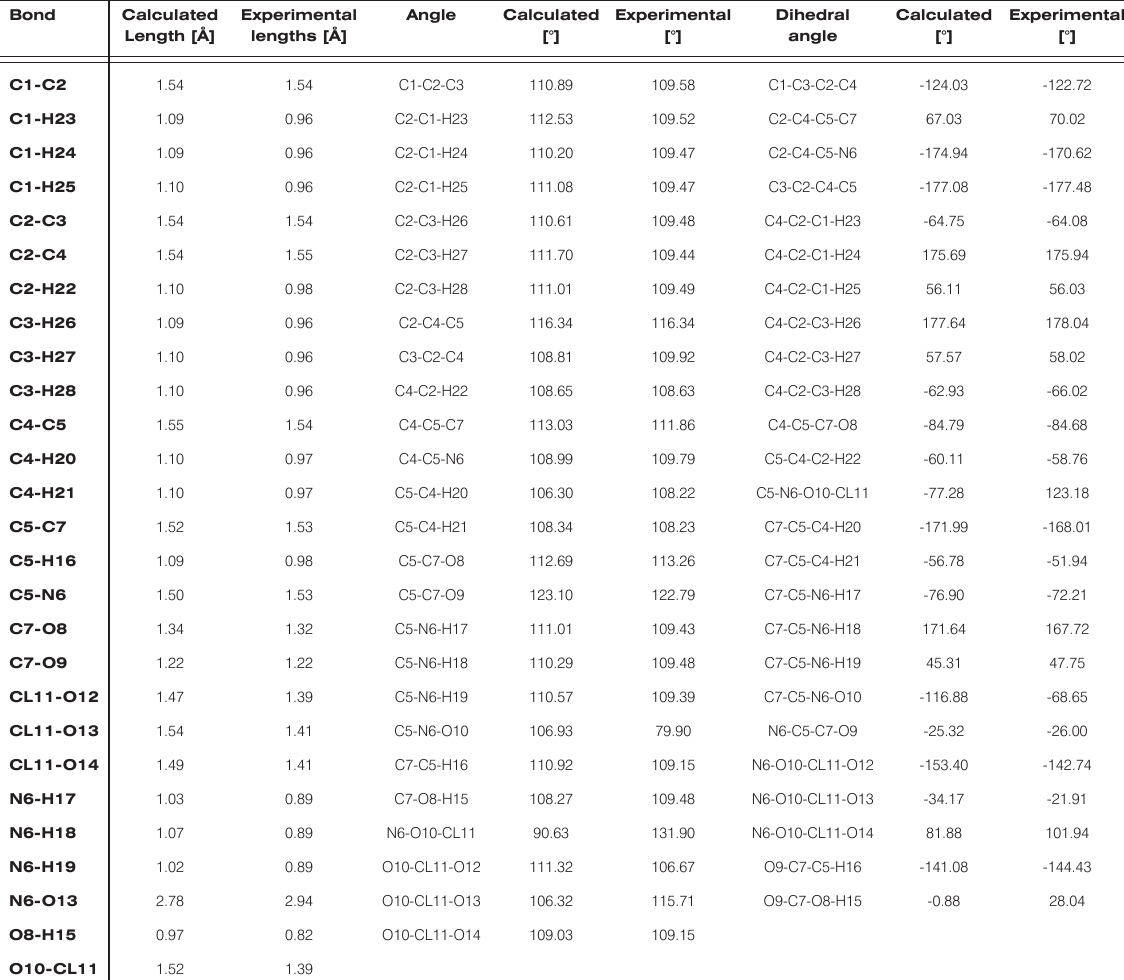
Table 3. Calculated geometric parameters for L-leucinium perchlorate. The data are compared with experimental values from [16].